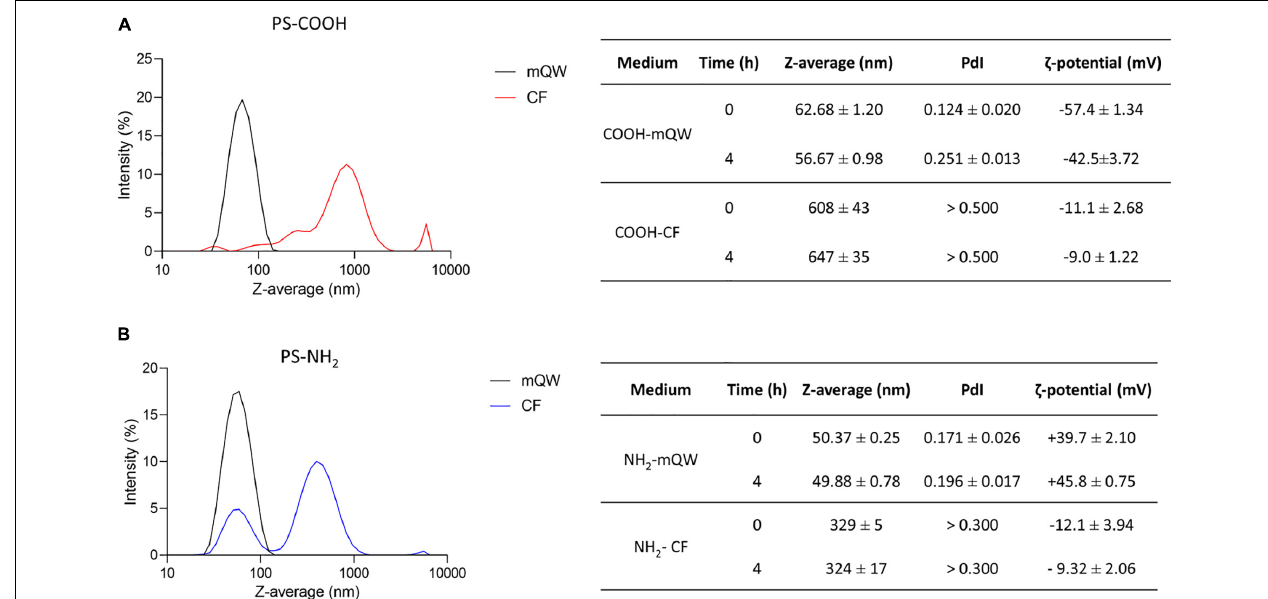
FIGURE 1 | Polystyrene nanoparticles behavior in exposure media. Particles size distribution and Z -average (nm), polydispersity index (PdI) and ζ -potential (mV) of unlabeled PS-COOH (A) and PS-NH 2 (B) in mQW and coelomic fluid (CF) at time 0 and 4 h. Data are referred to 25 µ g mL − 1 of PS NPs and reported as mean ± SD ( n =